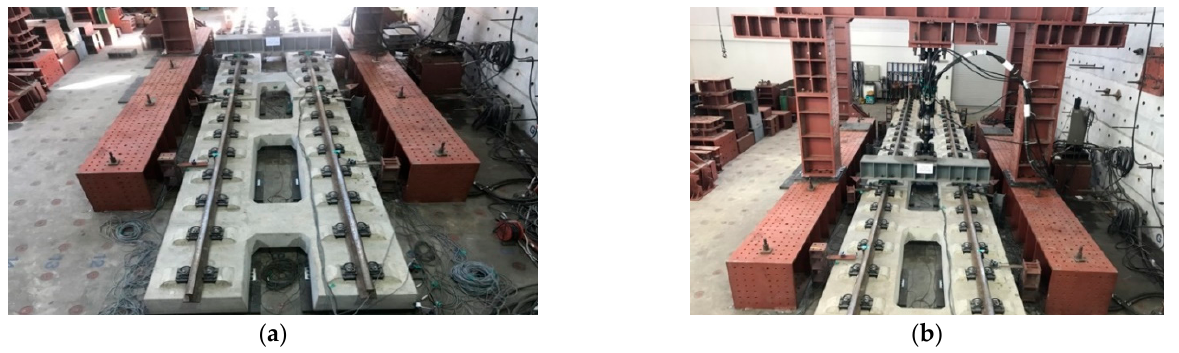
Figure 6. Structural assembly of three slab panel with 60 K rail: ( a ) Load case I: center loading point, and ( b ) Load case II: 2nd panel at 4/4 loading point test.